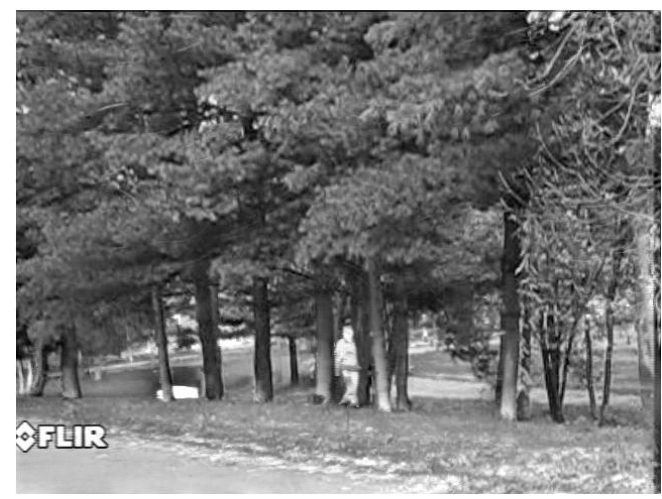
Figure 4. Fused image using the Laplacian pyramid.